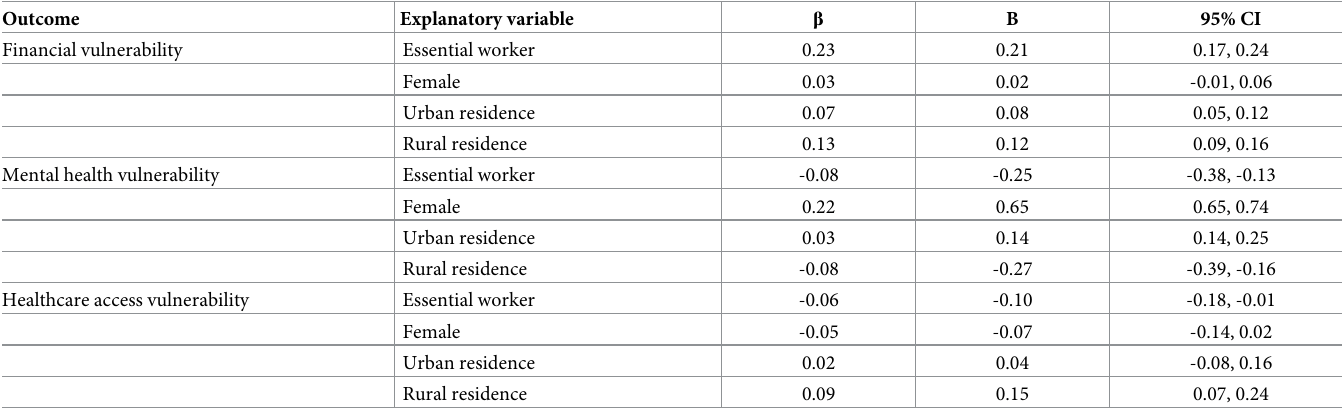
Table 2. Final model paths: Standardized coefficients and unstandardized coefficients with 95% confidence intervals, N = 2,800, April 2020.